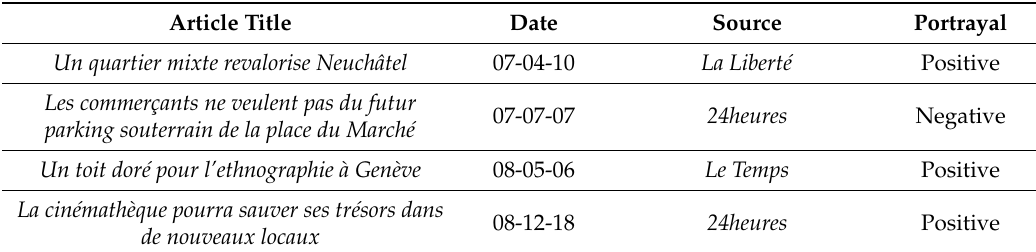
Table A1. Title, data, source and overall portrayal of the press articles reviewed, presented